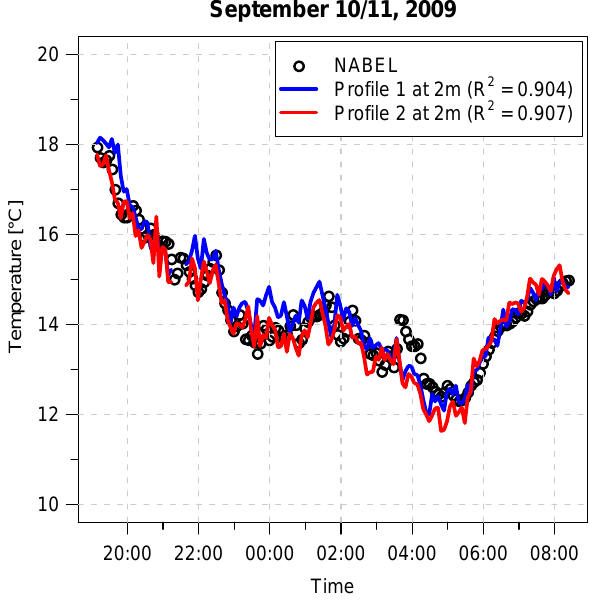
Fig. 3. Comparison of DTS temperatures measured 2m above ground and air temperature measurements from the collocated NABEL network station (cf. Fig. 1 for definition of profiles). Cor- relations between DTS measurements and NABEL data are given in the